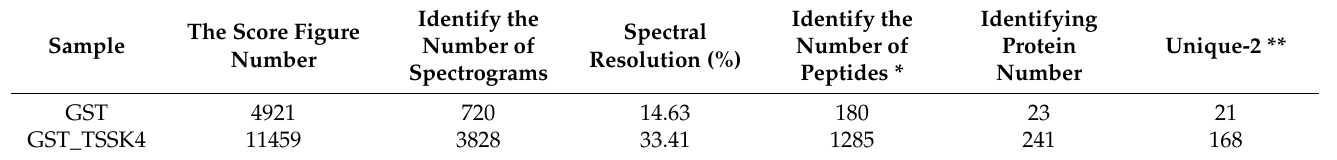
Table 5. Summary table of the protein identification information statistics.